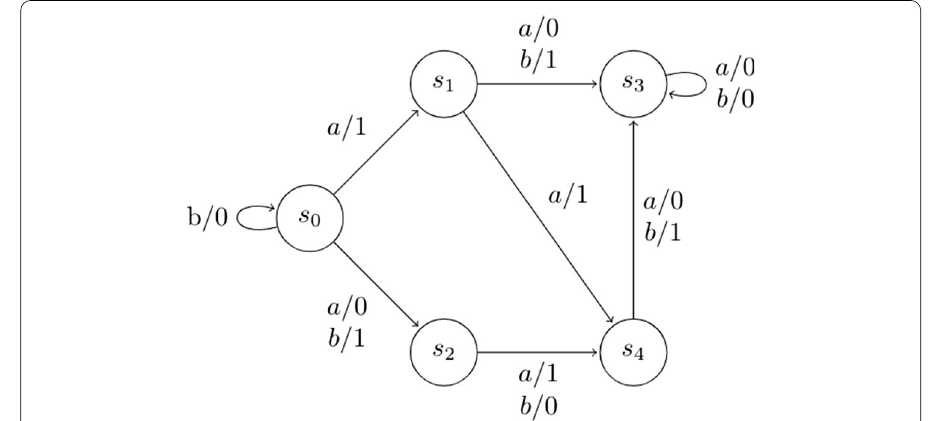
Fig. 1 Finite State Machine